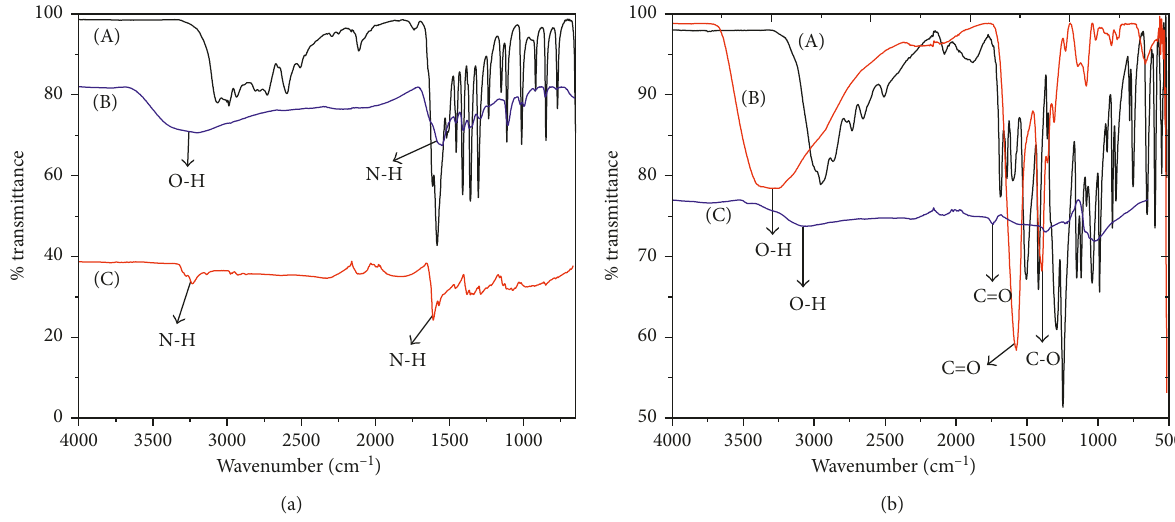
Figure 1: Infrared spectra of (a) (A) pristine L -alanine, (B) L -alanine-capped ZnS nanoparticles, and (C) L -alanine-capped CuS nano- particles and (b) (A) pristine L -aspartic acid, (B) L -aspartic acid-capped ZnS nanoparticles, and (C) L -aspartic acid-capped CuS